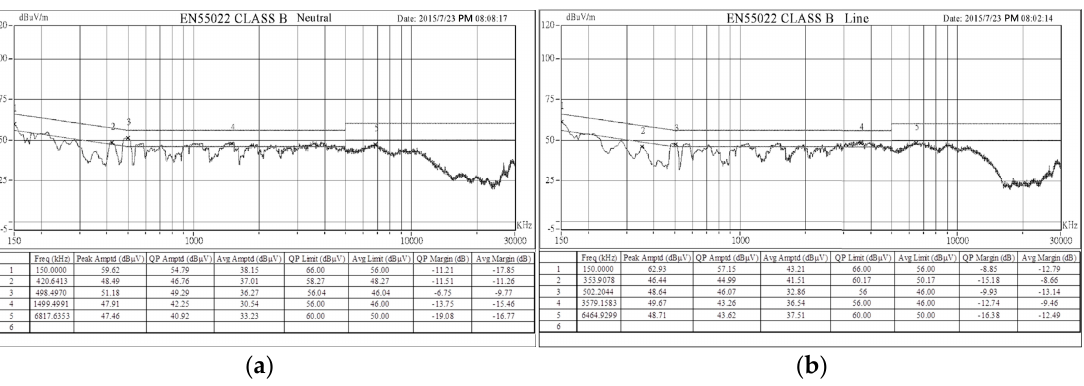
Figure 23. Conducted EMI measurements in the X -capacitor of 0.22 μ F (±9% frequency swapping): ( a ) Neutral; ( b ) Line.